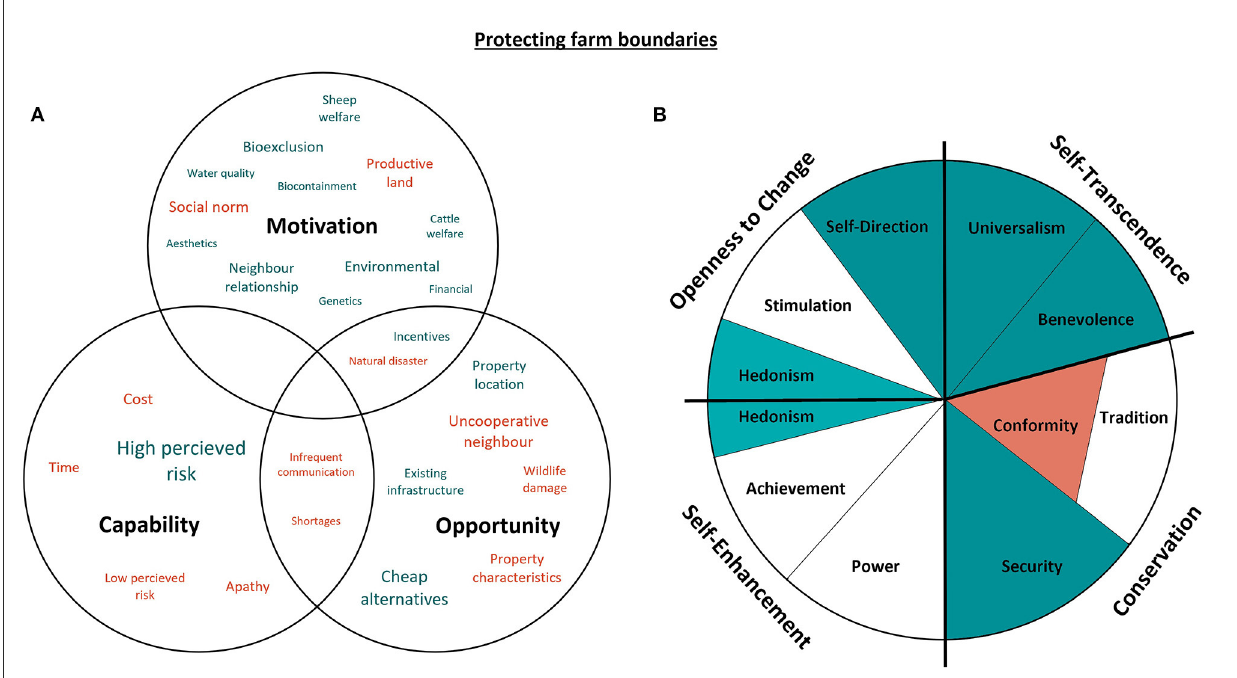
FIGURE6 Capability, opportunity, motivations and values associated with protecting farm boundaries. Green represents attributes that promote the boundary protection, while red indicates confounding attributes. The size of the text in (A) indicates the commonality of themes amongst the participants, as does darker shading in (B) [adapted from Schwartz (29). CC BY-SA